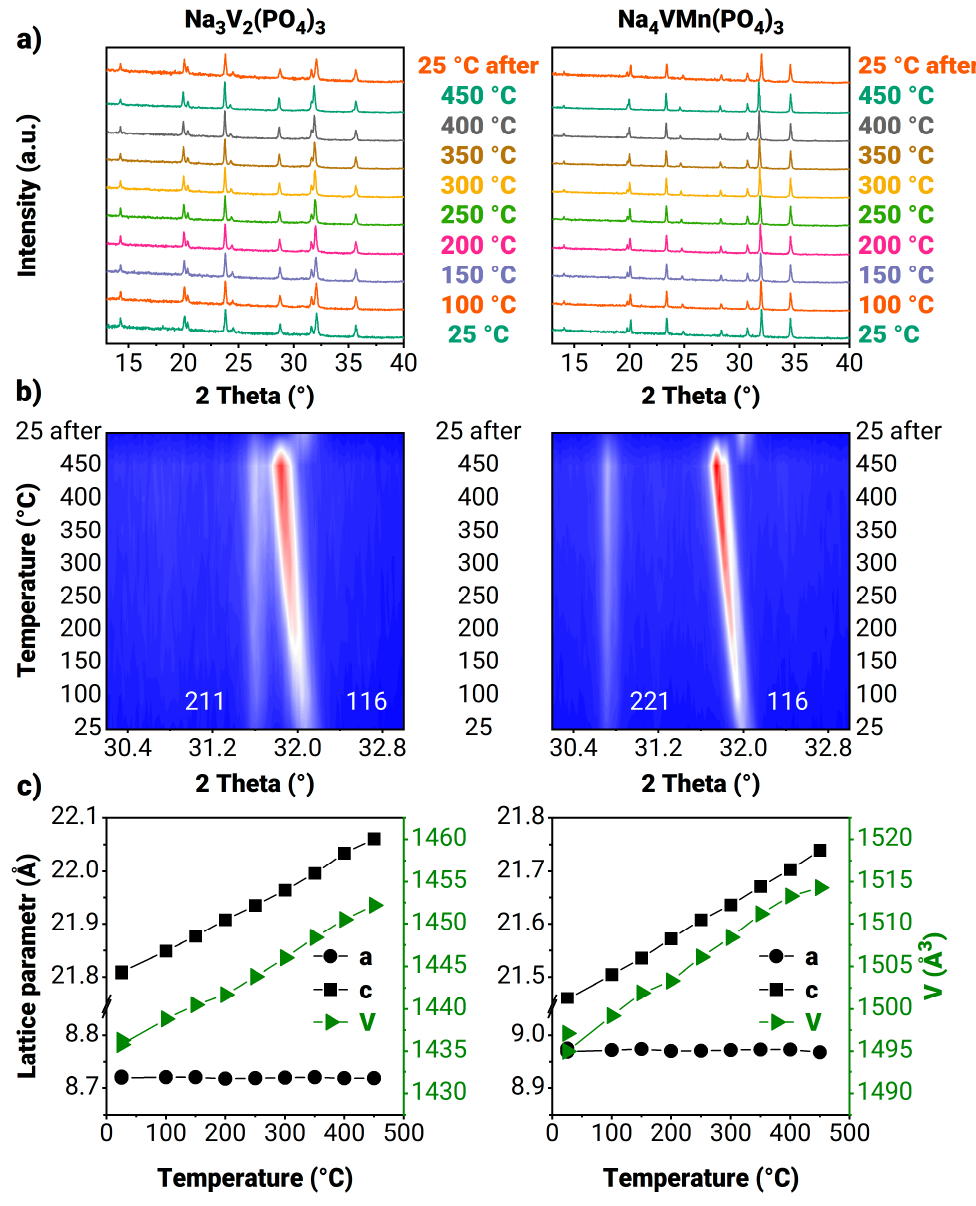
Figure 5. ( a ) In situ HTPXRD patterns for pristine powders of Na 3 V 2 (PO 4 ) 3 and Na 4 VMn(PO 4 ) 3 cathode materials, ( b ) heat plot of 211 and 116 reflections (30.3–32.9°) and ( c ) lattice parameters. cathode materials, ( b ) heat plot of 211 and 116 reflections (30.3–32.9 ◦ ) and ( c ) lattice